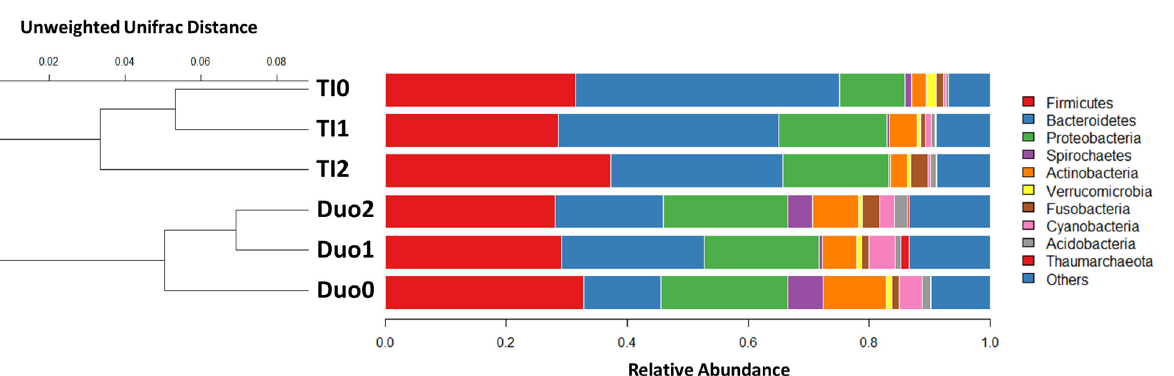
Figure 2. Unweighted Pair-group Method with Arithmetic Mean (UPGMA) analysis to assess and compare alpha and beta diversity across tissues and study groups. The bar chart depicts the rela- tive abundance of bacteria at the phyla level for both the duodenum (Duo) and terminal ileum (TI). The dendrogram on the left allows comparison across tissues and study groups, highlighting the largest degree of difference between Duo and TI, Duo0 & TI0-Controls, Duo1 & TI1-Active CD at that biopsy site, and Duo2 & TI2-CD without active inflammation at that biopsy site, but present elsewhere.